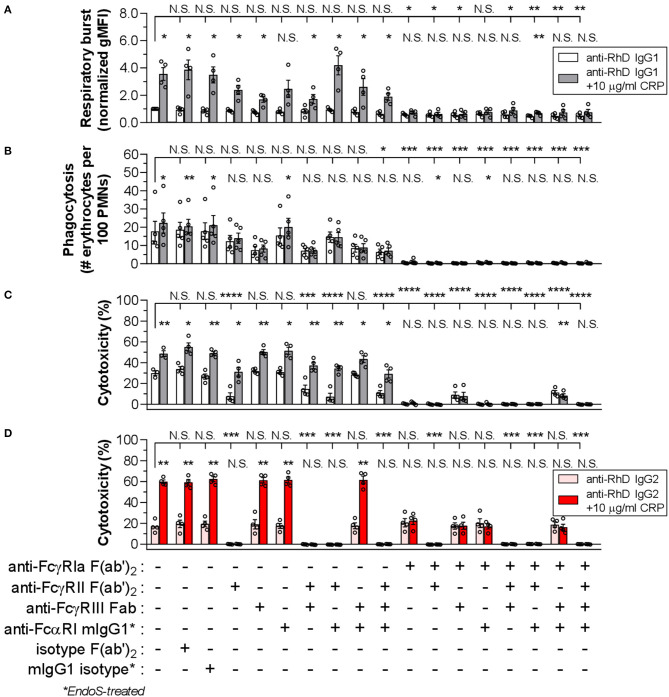
FcγRIa is mainly responsible for CRP-mediated enhancement of PMN effector functions. The role of FcRs in IgG1-mediated PMN respiratory burst activity (A), phagocytosis (B), and cytotoxicity (C) was determined using a panel of FcR blocking agents in the presence (gray bars) or absence (white bars) of CRP (10 μg/ml). For blocking, effector cells were pre-incubated with the respective blocking agent, or isotype equivalent for control purposes, at a concentration of 10 μg/ml. An IgG1 concentration of 0.125 μg/ml was used for respiratory burst and phagocytosis tests, and 0.01 μg/ml for cytotoxicity assay. For respiratory burst data, gMFI values from conditions without blocking and CRP were normalized to 1.0. Phagocytosis is depicted as phagocytic index (# erythrocytes per 100 neutrophils) and cytotoxicity as the percentage (%) of lysed target erythrocytes. Respiratory burst and cytotoxicity blocking experiments have been performed using G-CSF/IFN-γ-stimulated PMNs from 4 donors tested in three independent experiments and phagocytosis tests for 5 donors tested in four independent experiments. (D) Similarly, the role of FcRs in IgG2-mediated cytotoxicity was determined in the presence (red bars) or absence (pink bars) of CRP (10 μg/ml), using the same panel of FcR blocking agents and an IgG concentration of 0.5 μg/ml was used. IgG2-based cytotoxicity assays have been performed in three independent experiments using G-CSF/IFN-γ-stimulated PMNs from 4 FcγRIIaH/H131 donors. Bar graphs indicate the mean value ± S.E.M. of data points (circles) each representing the mean of duplo (A,B) or triplo (C,D) values. Significant differences between blocking conditions have been determined using one-way ANOVA and two-tailed paired t-test was used to determine significant differences between conditions with or without CRP. *p ≤ 0.05; **p < 0.01; ***p < 0.001; ****p < 0.0001; N.S. not significant.